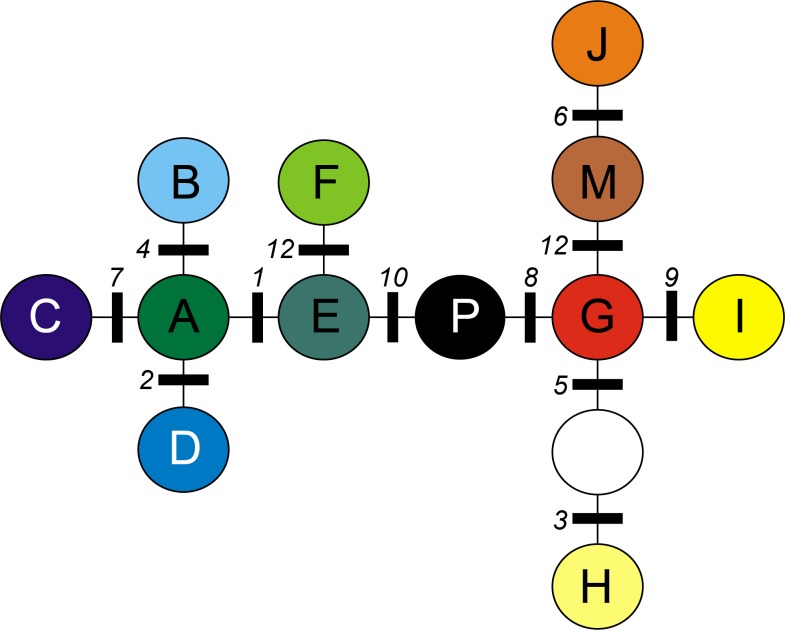
Minimum spanning tree (MST) presenting relationships between cpDNA haplotypes in A. halleri.Coloured circles represent haplotypes, white circle represent missing haplotype. Numbers indicate mutations as given in Table 2.